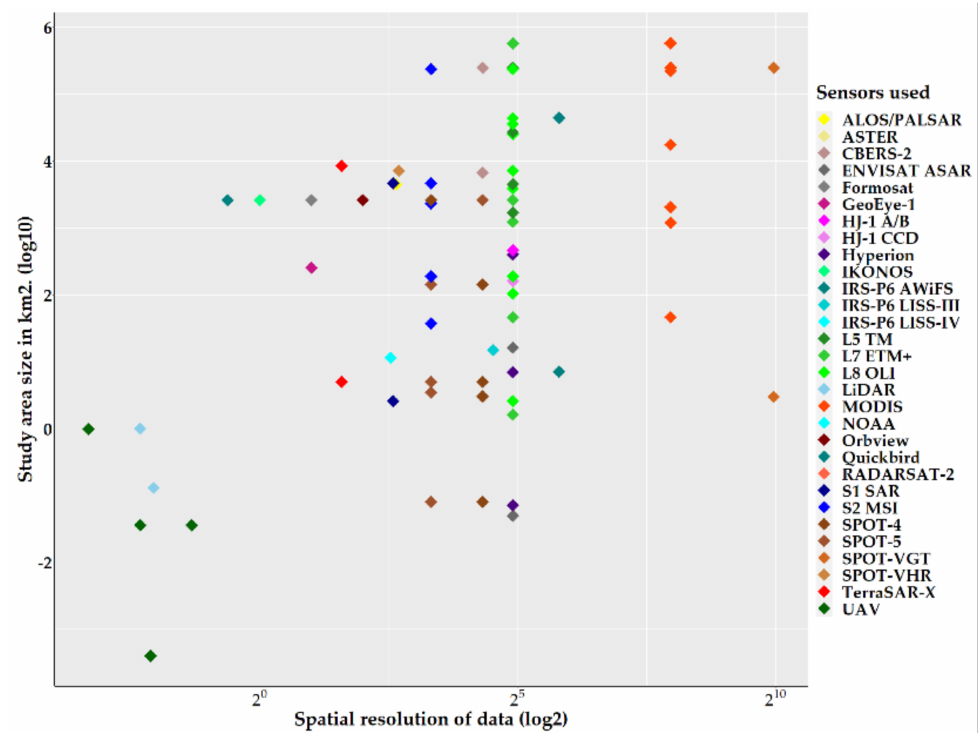
Figure 14. Scatter plot of study area and sensor spatial resolution of the